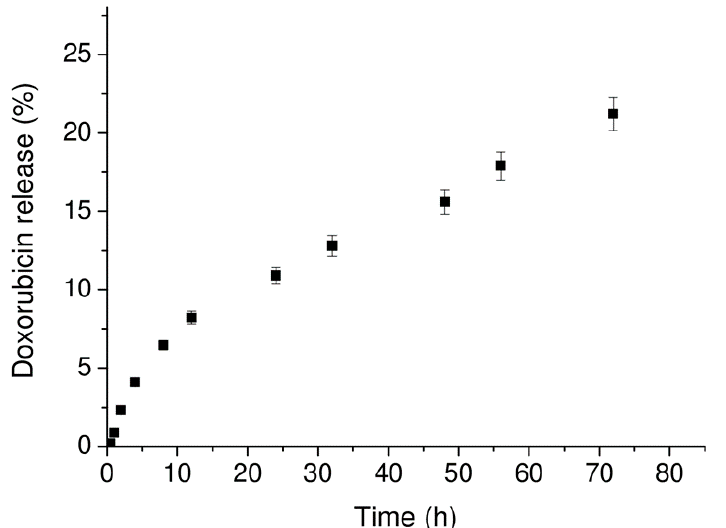
Figure 6. Doxorubicin release profile by Fmoc-FF PBNs. The amount of Dox released was estimated by fluorescence spectroscopy at 590 nm.